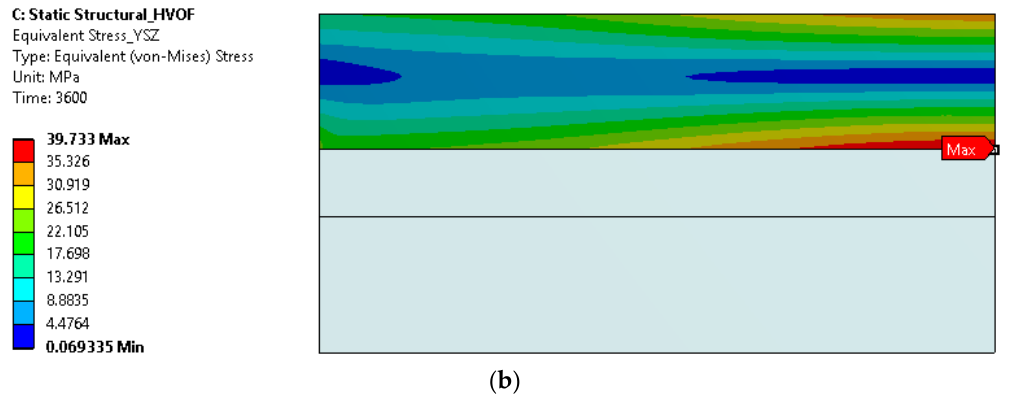
Figure 12. Temperature distribution in the coatings ( a ) during the heating cycle and ( b ) during the cooling cycle.